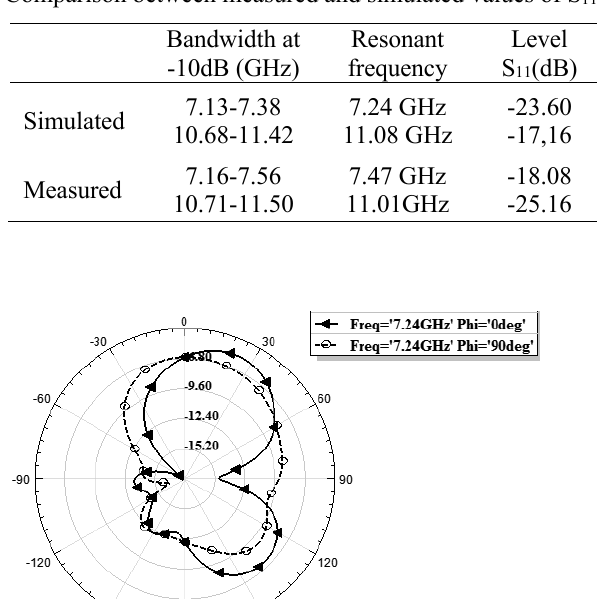
Table 3: Comparison of previous designs with the